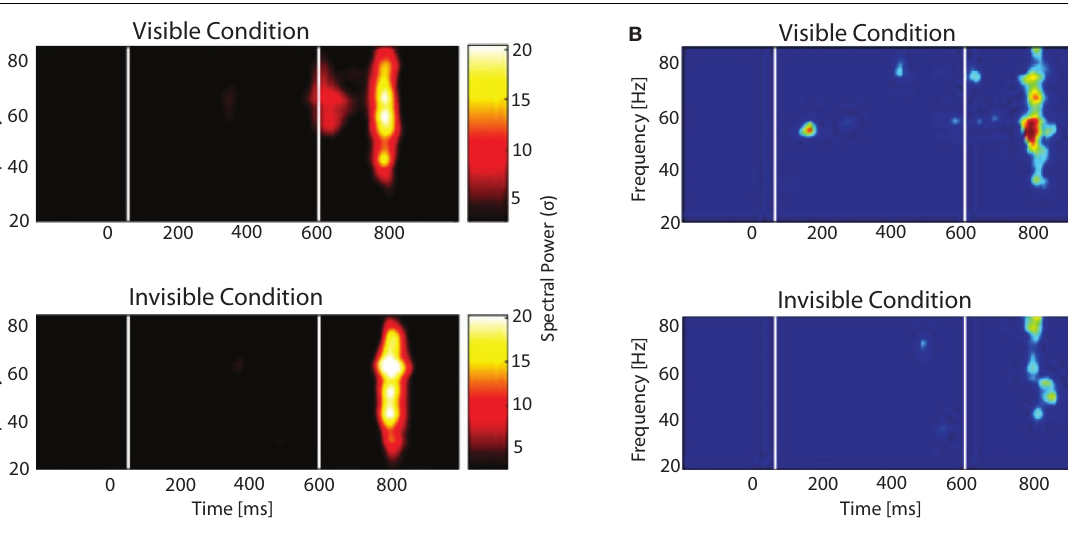
FIGURE 6 | Spectral power and phase synchrony to visible and invisible words. Words were fl ashed for 33 ms and surrounded by masks that depending on their luminance rendered the stimuli either visible or invisible. After around 500 ms a second word was presented and subjects had to determine whether it was the same or different from the previously presented word. (A) Time-frequency plot and (B) Phase synchrony plot shows the grand average for